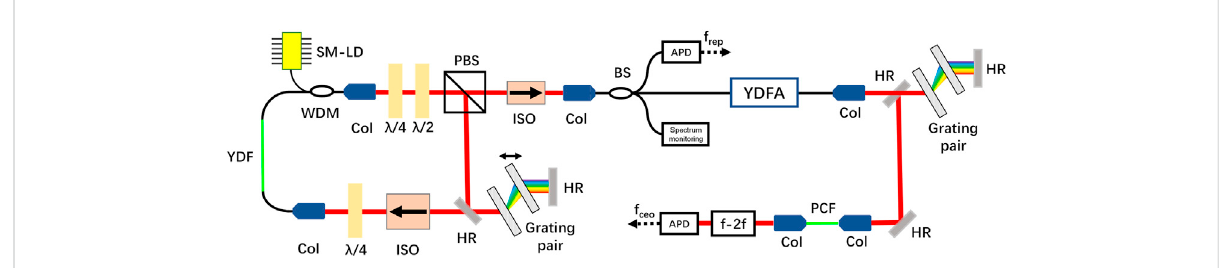
Experimentalsetup.SMLD,single-modelaserdiode;YDF,Yb:doped fi ber,Col,collimator;WDM,wavelengthdivisionmultiplexer; λ /4,quarter- wave plate; λ /2, half-wave plate; ISO, isolator; PBS, polarizing beam splitter; HR, high re fl ection mirror; BS, beam splitter; YDFA, Yb: doped fi ber ampli fi er;APD,avalanchephotodetector;PCF,photoniccrystal fi ber, f ceo :carrier-envelopeoffset;Blacksolidline,passive fi ber;Greensolidline,gain fi ber or PCF; Red solid line, optical path, Black dashed line: electronic wire.